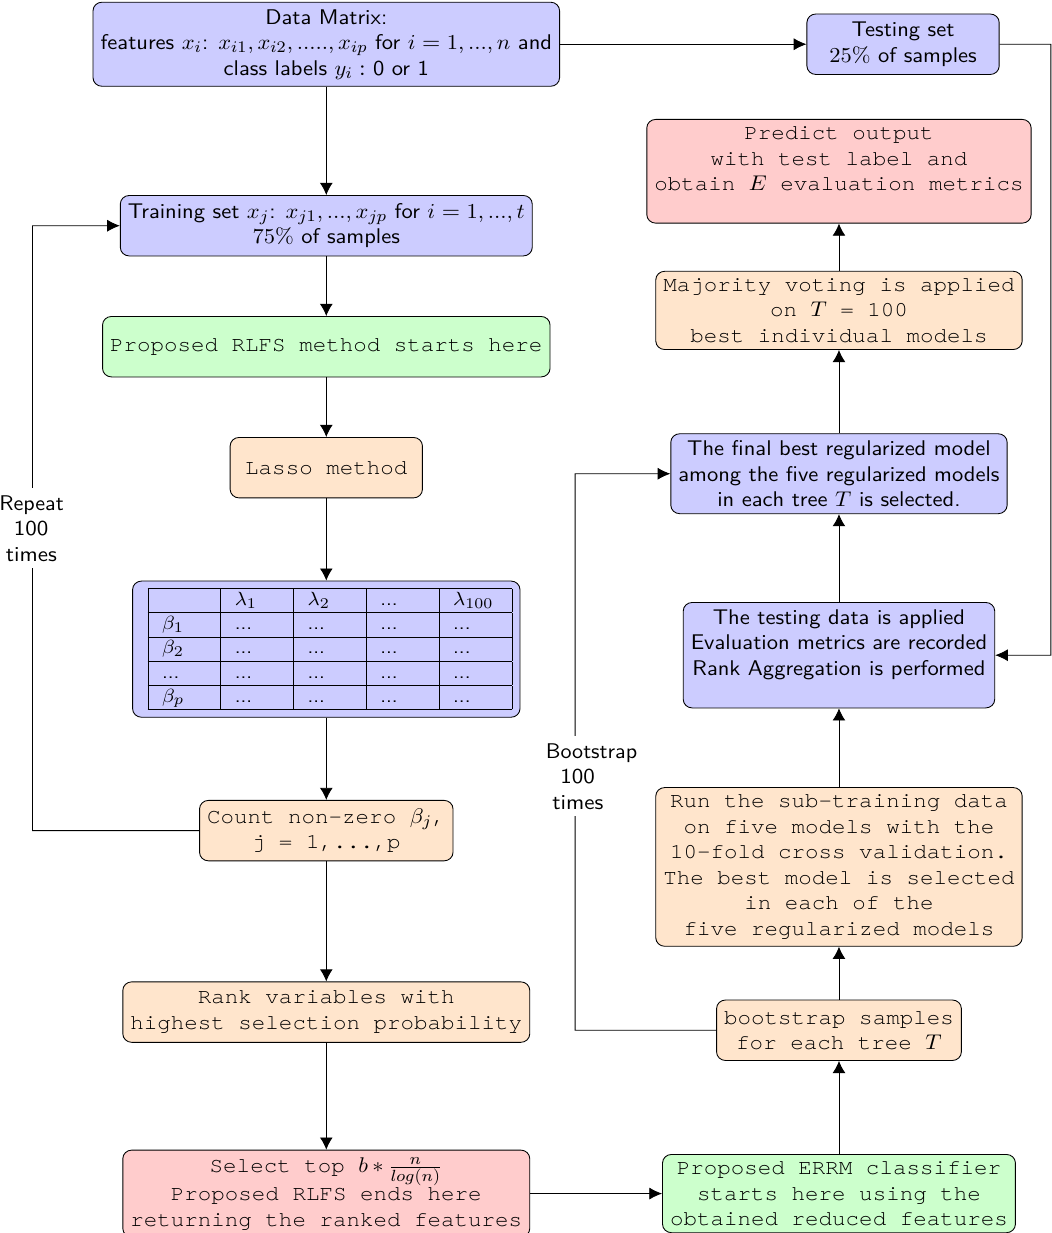
Figure 1. The complete workflow depicting the proposed combination of RLFS-ERRM framework